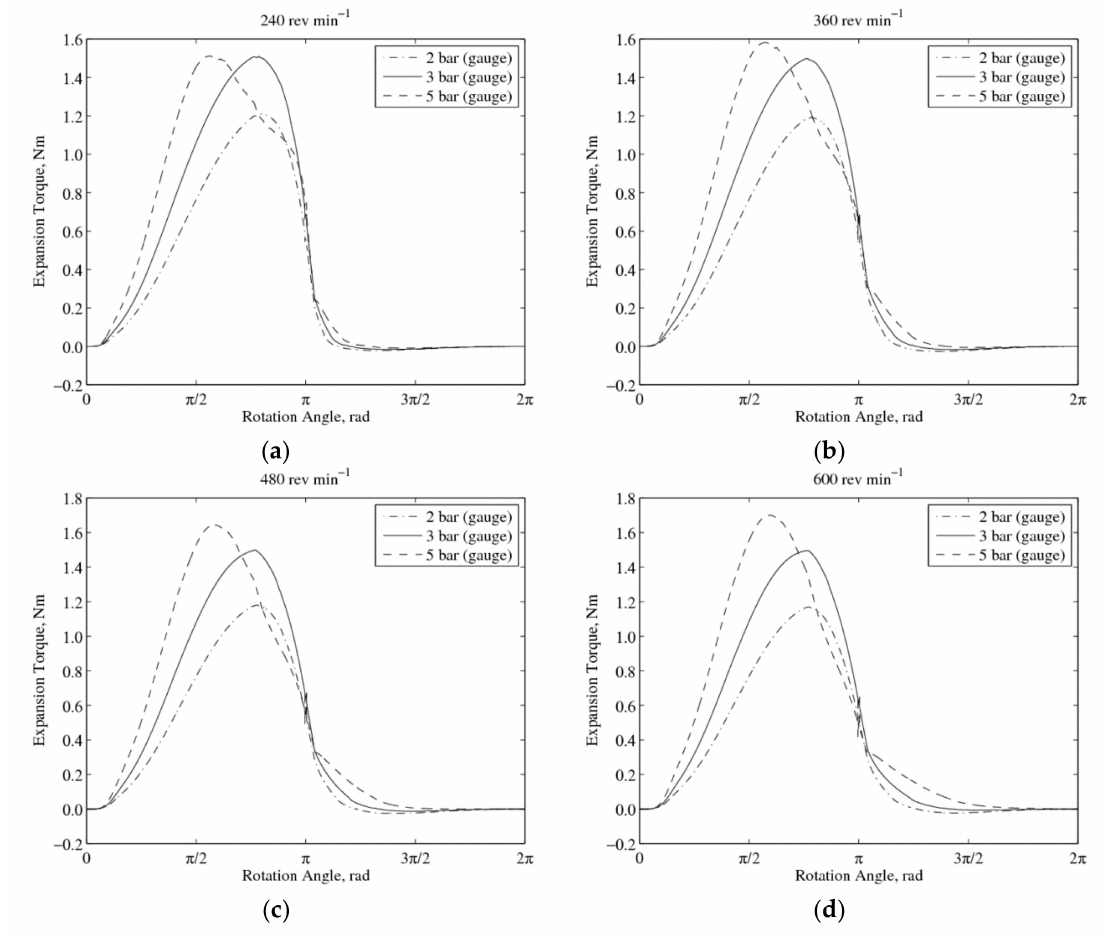
Figure 10. Variation of expansion torques at di ff erent speeds: ( a ) 240 rev min − 1 ; ( b ) 360 rev min − 1 ; ( c ) 480 rev min − 1 ; ( d ) 600 rev min − 1